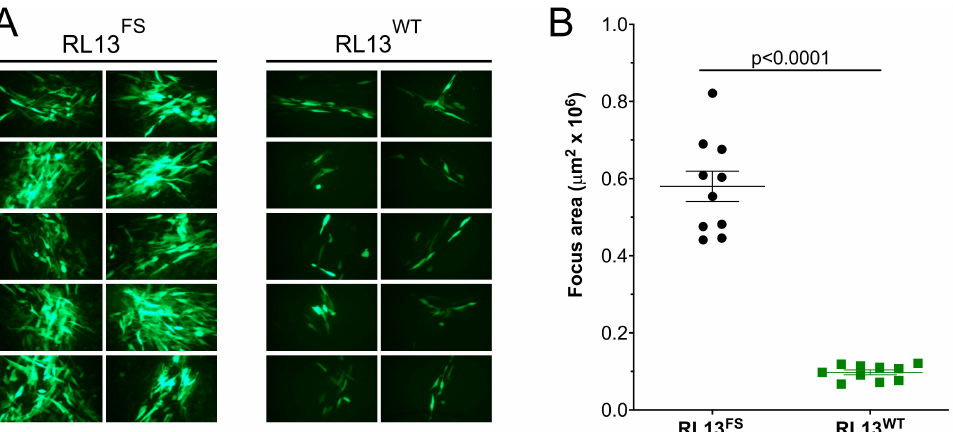
Figure 2. Repair of RL13 reduces focus size in the CMV Towne-varL genetic background. MRC-5 fibroblast monolayers were infected at low MOI with p0 stocks of viruses TL12-RL13 FS or TL12- RL13 WT . ( A ) After eight days, ten GFP+ foci formed by each virus were randomly selected and photographed. ( B ) Areas of GFP+ foci measured using the ImageJ software ( p value from Student’s two-tailed t -test). Original magnification: 100 ×